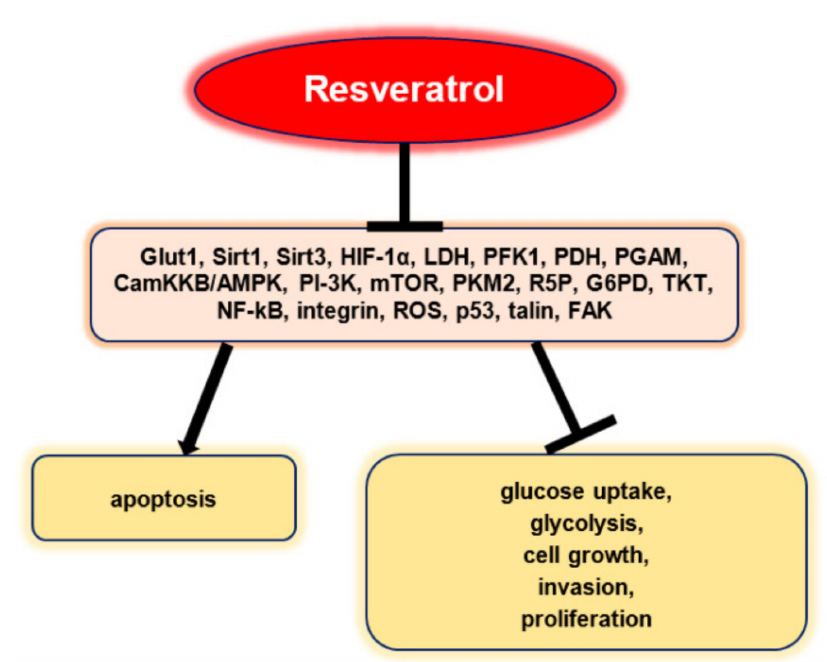
Figure 5. Resveratrol’s anti-neoplastic effects via the regulation of tumor glucose metabolism